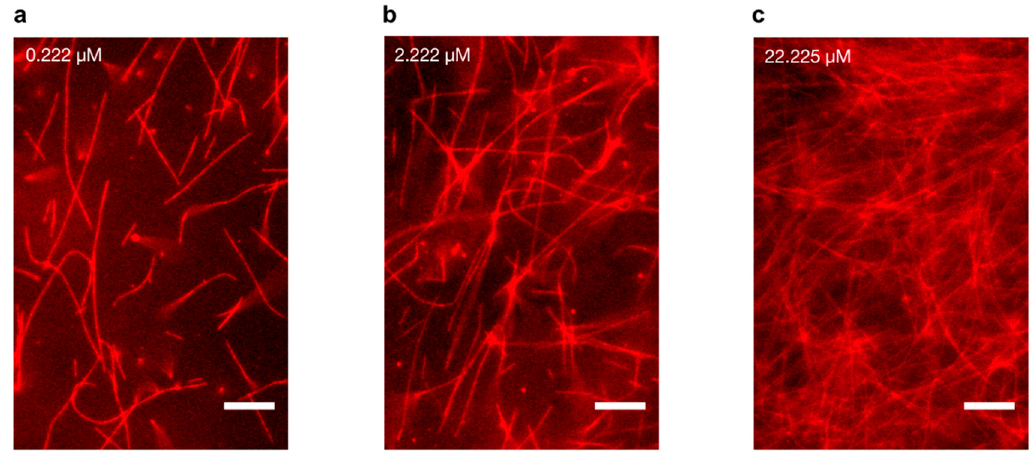
Figure 2. Microtubule imaging at di ff erent tubulin concentrations. Polymerisation was performed using 45 µ M tubulin, and MTs were stabilised with 50 µ M paclitaxel, and subsequently diluted to a final concentration of ( a ) 0.222 µ M tubulin ( b ) 2.222 µ M tubulin ( c ) 22.225 µ M tubulin, respectively. Scale bars represent 10 µ m.